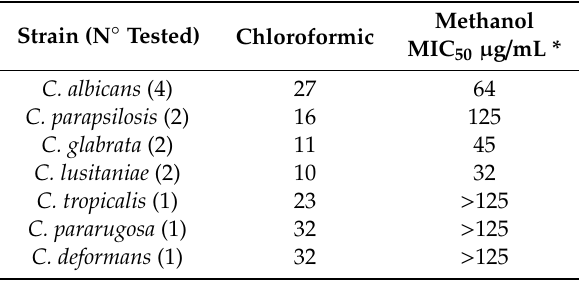
Table 2. Anti- Candida activity of leaves extracts from H. mexicanum .